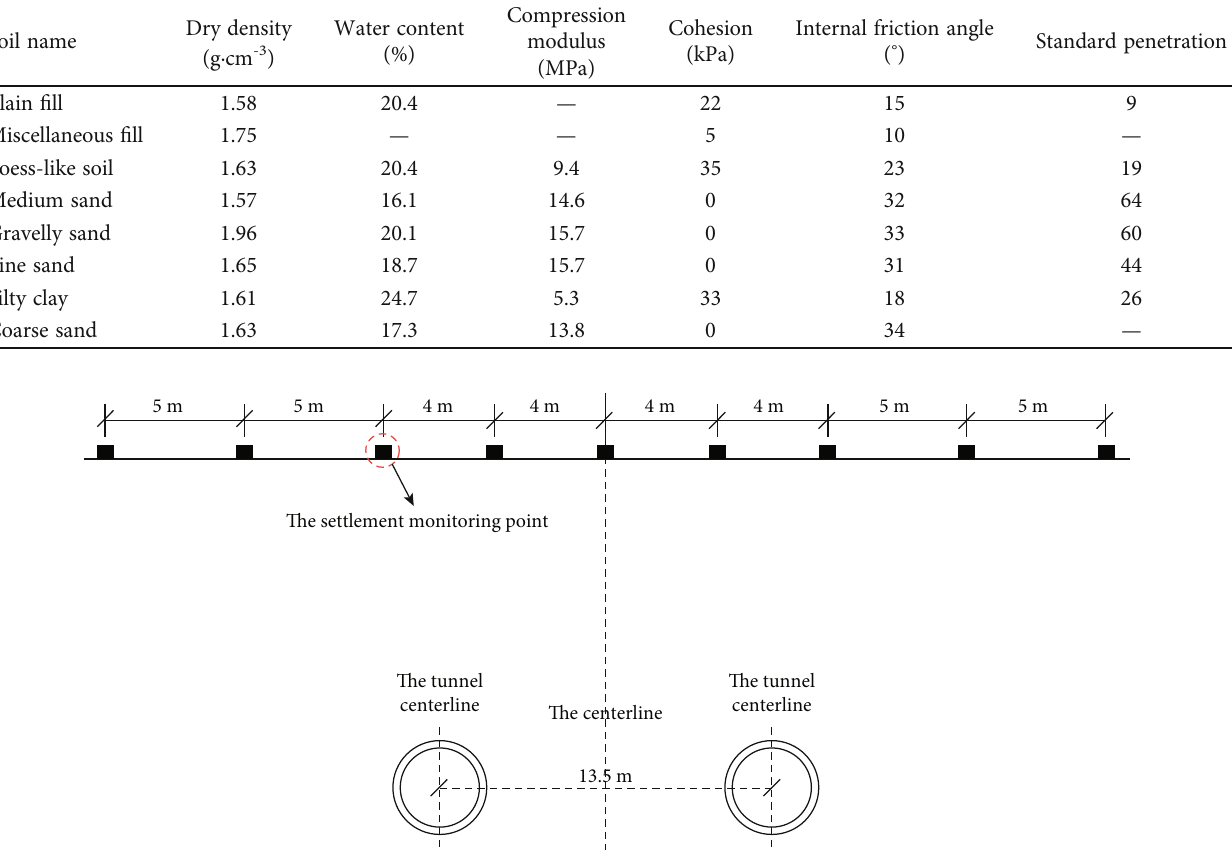
Table 1: Physical and mechanical parameters of the soil layer.